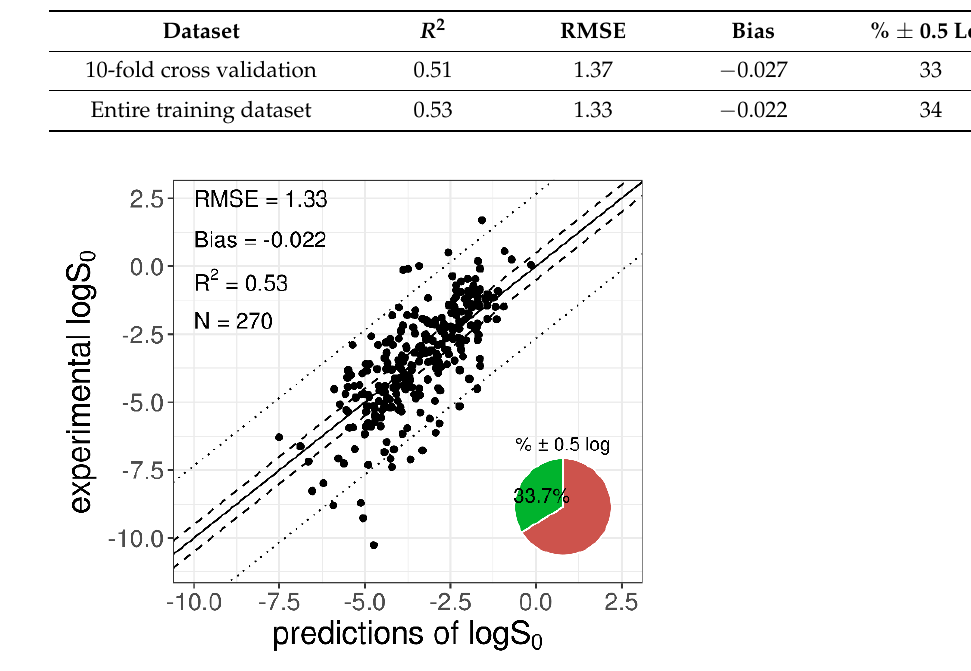
Figure 2. Plot of the experimental versus predicted logS 0 for the 270-compound training dataset. The solid diagonal line represents the identity line; dashed and dotted lines represent the displacement from the identity line by ±0.5 log and by ±2 × RMSE log, respectively. The pie chart refers to the percentage of “correct” predictions (within % ± 0.5 log). Table 4. Statistical measures of prediction performances obtained for the SC-2 test datasets.